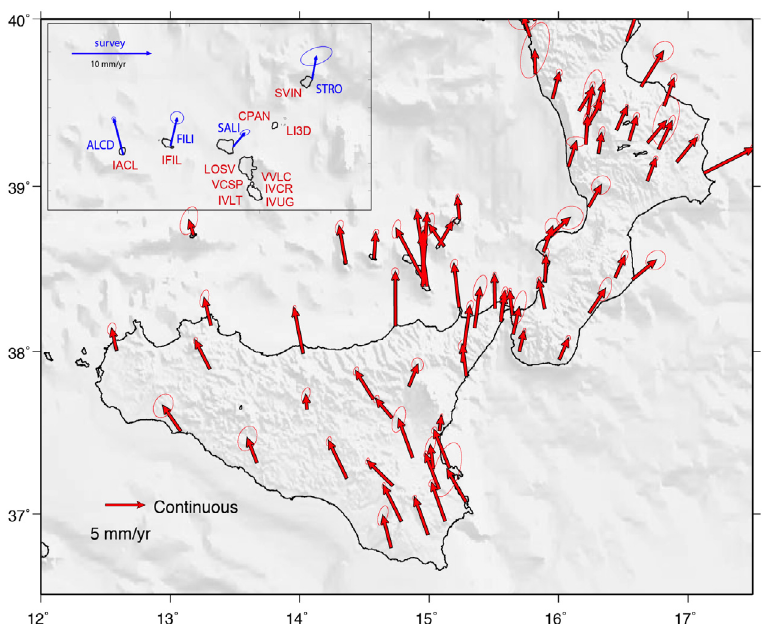
Figure 3. The geodetic velocity field for southern Italy, estimated from the CGPS regional network. In the inset are reported location and velocity of the CGPS (red arrows) and the regional survey style GPS stations (blue arrows) for the Aeolian Islands, analyzed in this paper. The closely spaced local networks at Lipari, Vulcano and Panarea are detailed in Figures 5 and 6.